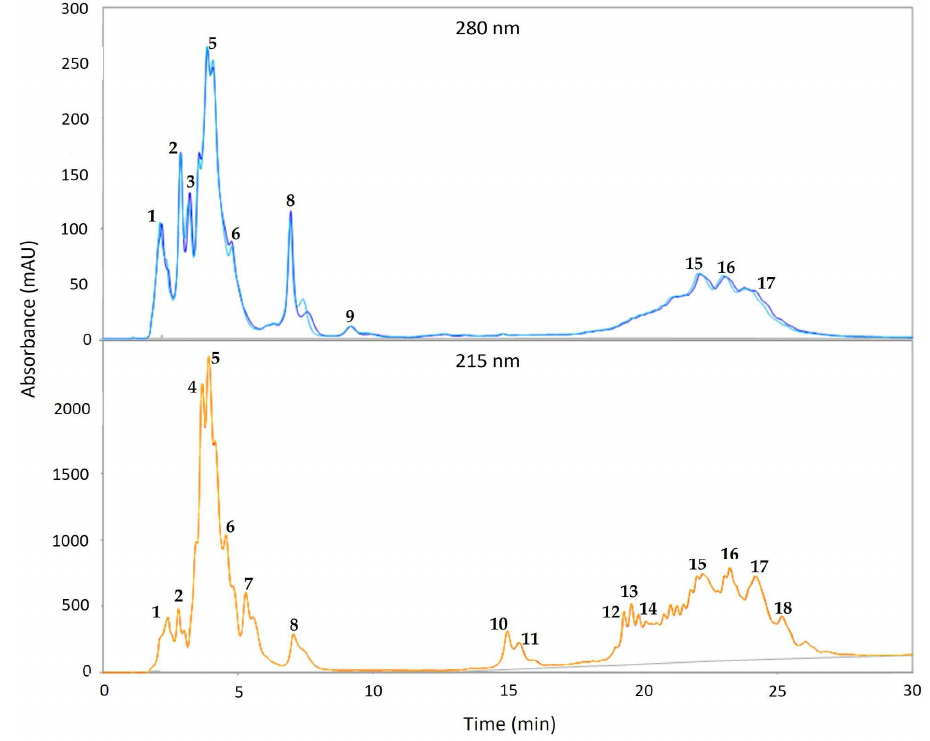
Figure 3. HPLC chromatograms at 280 and 215 nm of the validated optimal sPAG. Peak numbers were identified as follows: gallic acid #1; sAG triacylglycerols #18, phenolic monoacylglycerols #2, #5–6 and #8, phenolic diacylglycerols #15–17, monoacylglycerols #4 and 7, diacylglycerols #10–14, side reaction product #3 and 9.